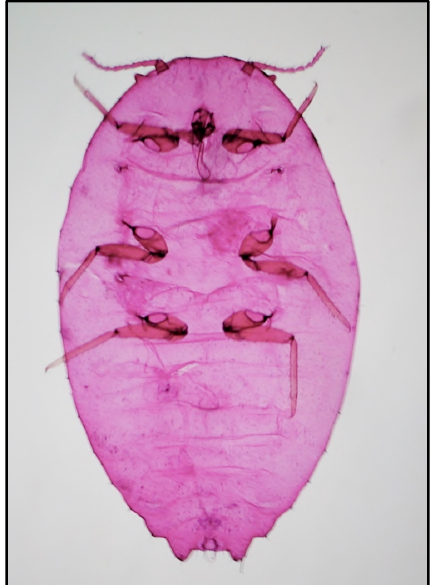
Figure 2. Slide-mounted female of Phenacoccus solenopsis .